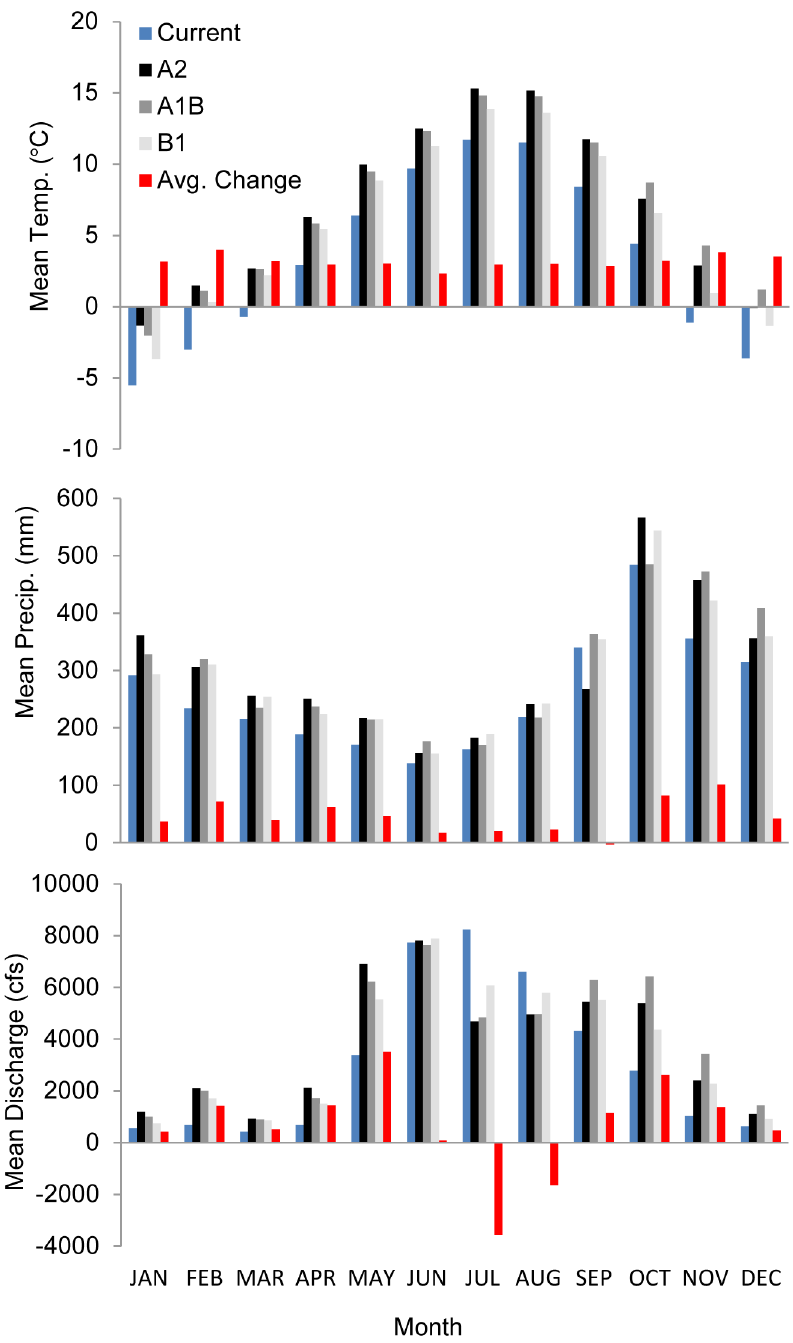
Figure 2. The historical mean (1961–1990) temperature ( 6 C), precipitation (mm), and modeled discharge (cubic feet per second) for the 41 analysis gauge station catchments in southeast, Alaska, USA. These are shown next to projected changes for the year 2080 using an ensemble global climate model average (ECHAM5, HadCM3, and CGCM3.1) and three global greenhouse gas emission scenarios (B1, A1B, and A2) using multiple regression-based monthly discharge